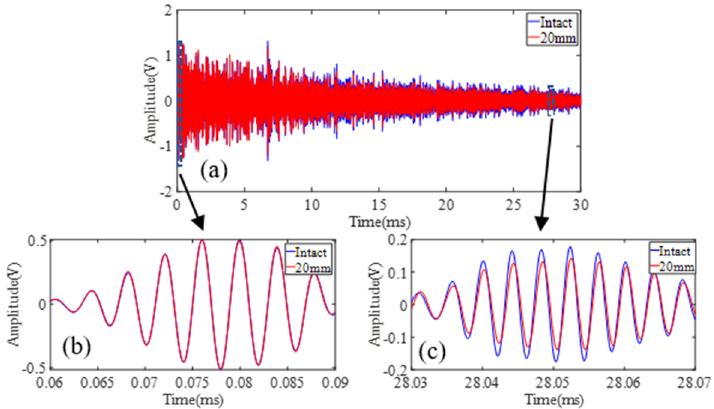
Figure 13. Signals obtained from intact rail (blue) and 20 mm condition (red): ( a ) full-length signal; ( b ) direct wave; ( c ) diffuse ultrasonic wave.